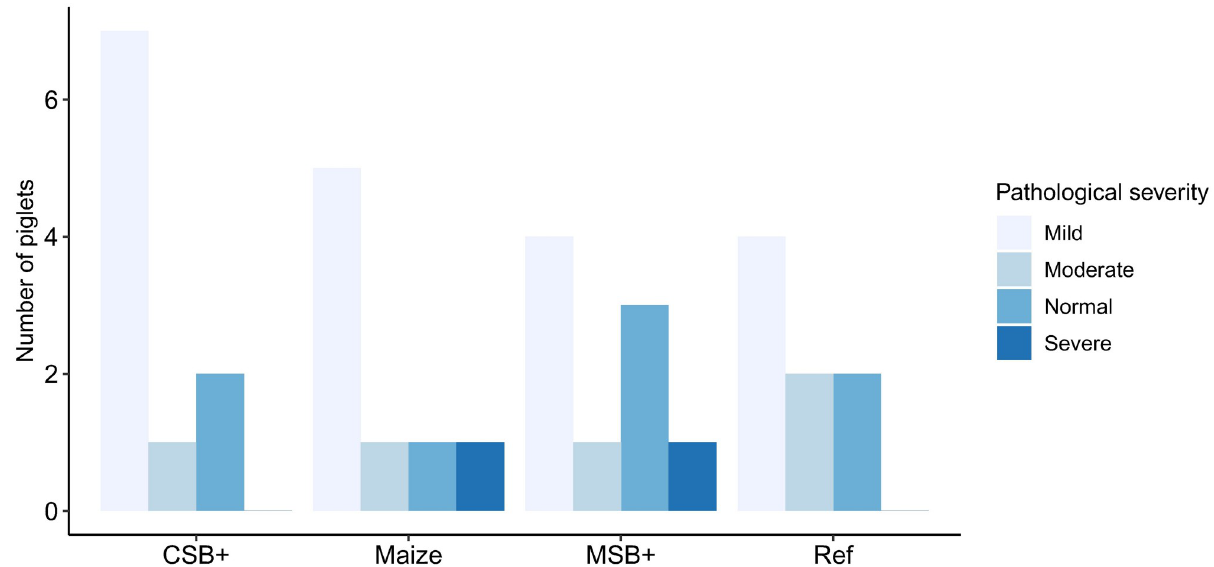
Fig 2. Pathological severity of distal colon in the experiment groups. One MSB+ sample was unavailable for histological assessment due to sample missing in the preservation.